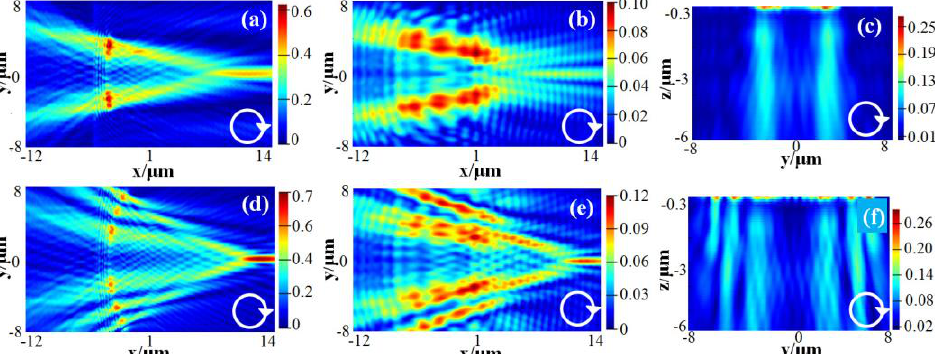
Figure 3. The simulated results for the influence of the center angle of circular arc slit on the transmitted electric field light intensity distributions for the case of ( a , b ) θ = 30 ◦ , ( d , e ) θ = 56 ◦ . The plasmonic sensor is illuminated by right − handed CPL. ( a , d ) correspond to near field at z o = − 200 nm, ( b , e ) correspond to far field at z o = − 6 µ m. ( c , f ) show the electric field light intensity distribution at y-z plane (i.e., x = 0 µ m, − 6 µ m ≤ z ≤ − 0.3 µ m) for the cases of ( a , b ) and ( d , e ), respectively. The amplitude of the incident light is set to 1.